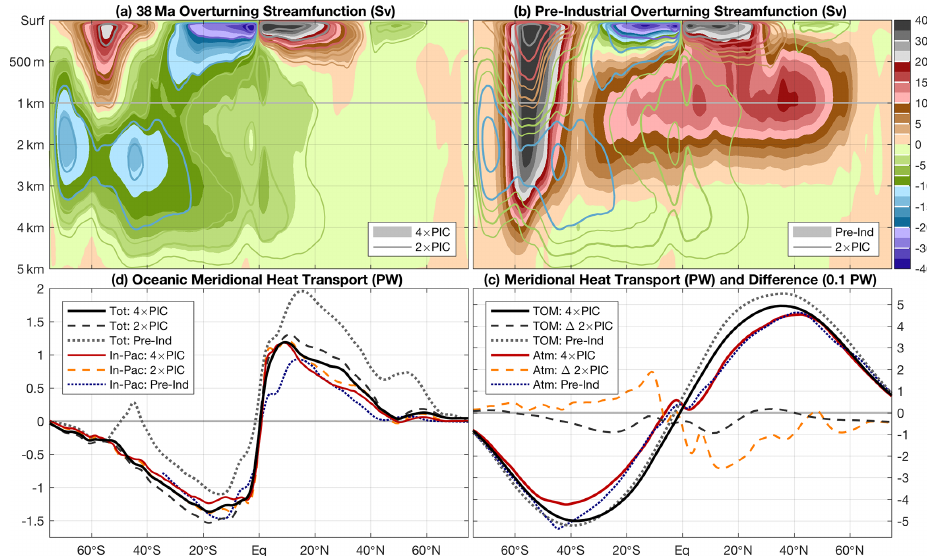
Figure 5. Global oceanic meridional overturning stream function averaged over the last 50 model years of the (a) 38Ma 4 × PIC (shading) and 2 × PIC (contours) simulations as well as the (b) pre-industrial reference (shading; 38Ma 2 × PIC again in contours). Contours are drawn using the same colour scale at levels indicated by white lines in the colour bar to the right. (c) Integrated meridional heat transport in the ocean, globally (greyscale) and Indo-Pacific only (coloured) for the three model cases. Note that the horizontal (latitude) scale covers the range [75 ◦ S, 75 ◦ N], with latitude increasing from left to right, for a better comparison with oceanic fields in (a) and (b) . The top-of-model (TOM) required total meridional heat transport is shown in (c) for 38Ma 4 × PIC (solid black) and the pre-industrial reference (dotted grey) with the corresponding atmospheric component in red (4 × PIC) and dotted blue (pre-industrial). Differences with respect to 38Ma 4 × PIC for both total (dashed dark grey) and atmospheric (dashed orange) heat transport are given for the 2 × PIC case, magnified